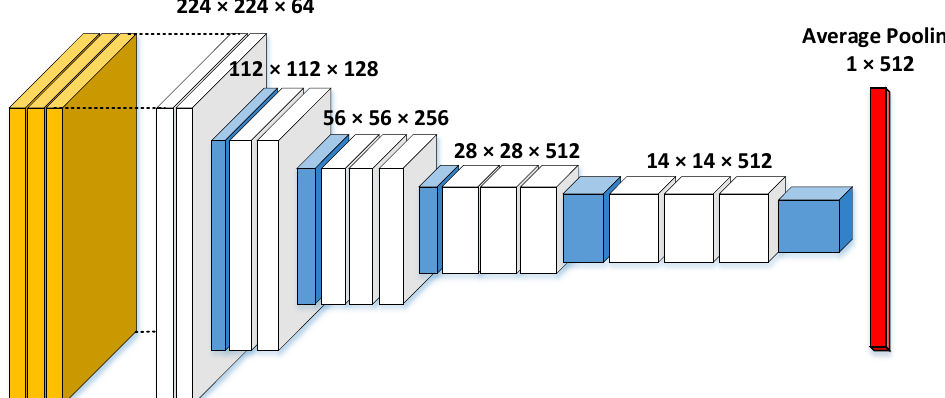
Figure 1. VGG19 network architecture adapted for transfer learning. Layers include convolutional (white), pooling (blue) and an average pooling layer (red). Classification layers were replaced with an average pooling layer to output a flat vector of extracted features.